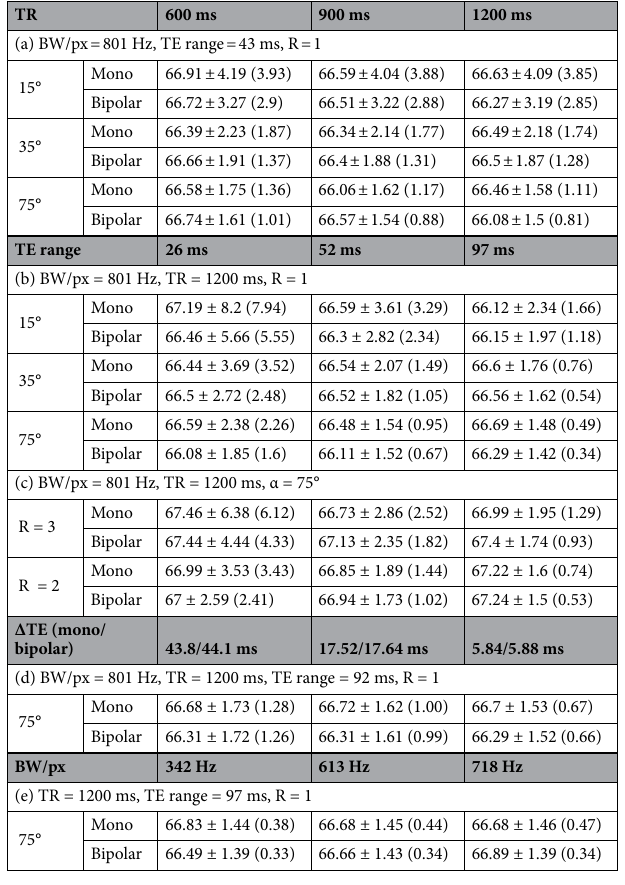
Table 2. Mean, standard deviation and relative difference of the standard deviation with respect to the (a) α and TR (b) α and TE range (c) R and TE range (d) ∆TE and (e) BW/px in phantom experiments. The values were calculated in ROI 3 (Fig. 2a). The numbers in parentheses are the standard deviations predicted from CRLB. As in the computer simulation, the standard deviation increases as the α, TR and TE range decrease. The standard deviation also increases with an increase in the R. (a-c) The difference between the two readouts tends to increase at a lower α, shorter TR, shorter TE range, and lower R. (d) When the TEs from each readout are similar and have the same BW/px, the monopolar and bipolar readouts provide similar precision. (e) When the monopolar and bipolar readouts have the BW/px of 718 and 342 Hz, respectively, both readouts